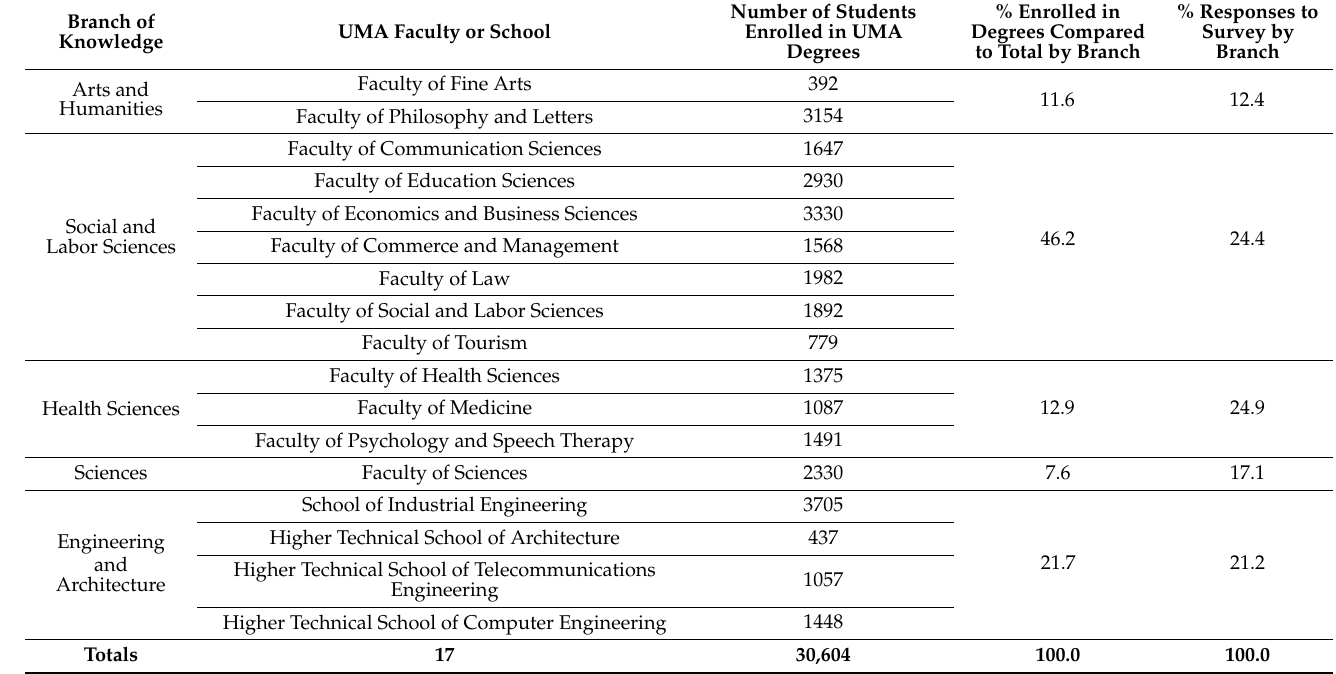
Table 3. Percentage of responses to the survey according to percentage of enrolled students in each branch of knowledge at the University of Malaga (UMA).